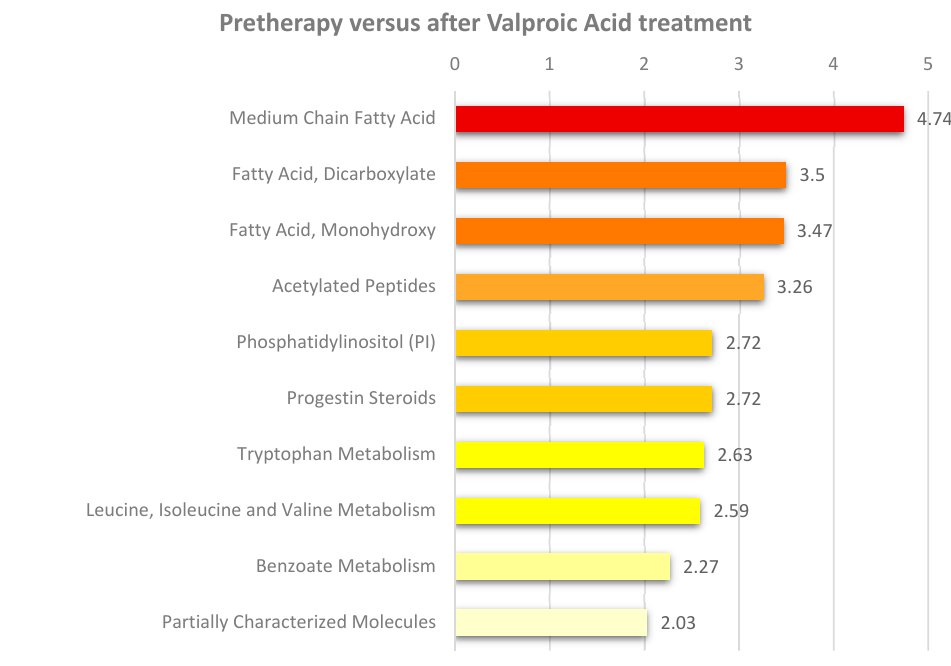
Table 1. An overview of significantly altered serum metabolites ( p < 0.05 and q < 0.05) after seven-day valproic acid therapy.